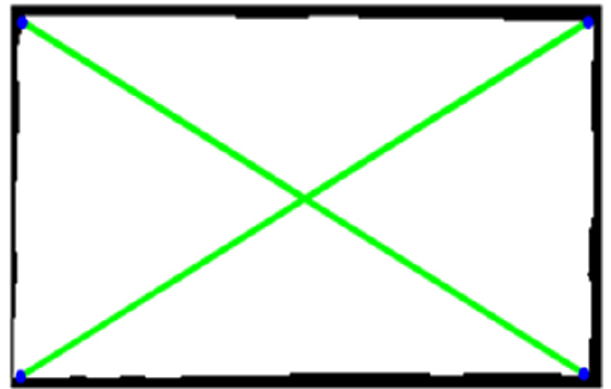
Figure 12. Location diagonal detection.